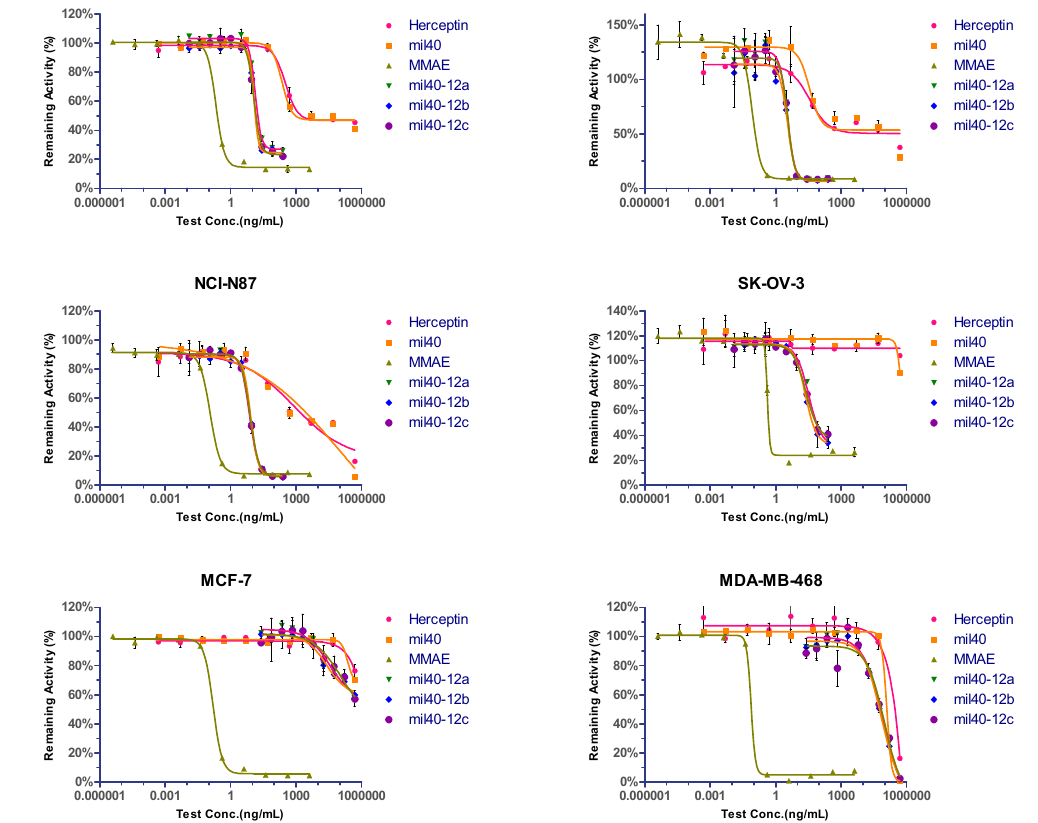
Table 1. Cytotoxicity of ADCs, antibodies and MMAE in cancer cell lines in vitro.